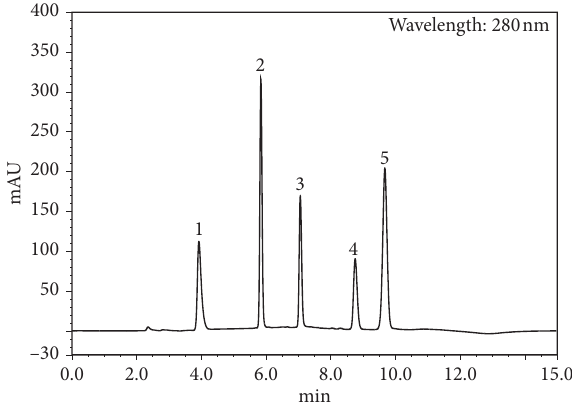
Figure 2: HPLC chromatograms of FSM (1), DPM (2), DBM (3), PTM (4), and APL